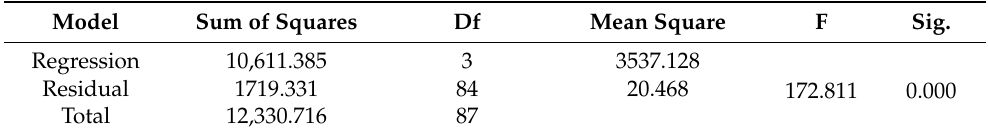
Table 1. ANOVA or F-test Results Statistics.